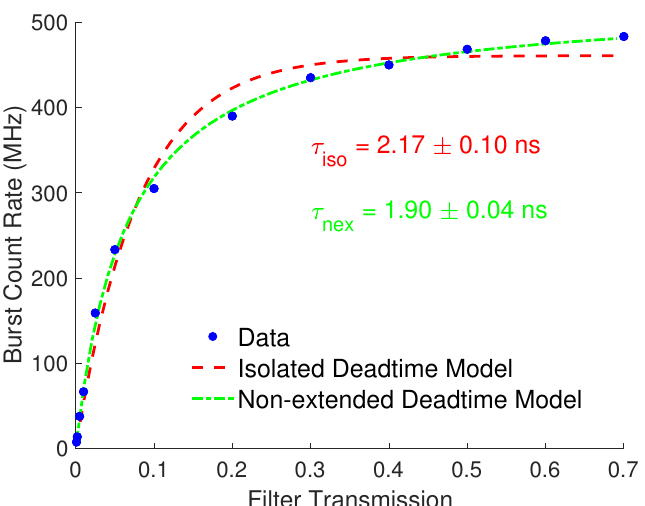
Figure 5. The observed APD count rate saturation that occurs as aluminum X-ray transmission filters are removed from in front of the detector is fitted to both an isolated dead-time model (Equation (1)) and a non-extended dead-time model (Equation (2)). Both models indicate the detection system dead-time is comparable to the minimum X-ray pulses separation of 2.00 ns. The error bars from counting statistics in the observed count rate are less than 1% for observed count rates above 100 MHz and too small to be seenn on this